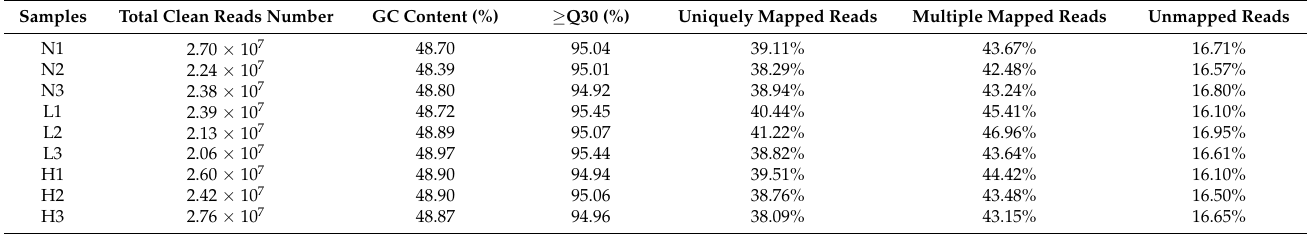
Table 1. Evaluation statistics of Illumina results and mapping efficiencies ( n =